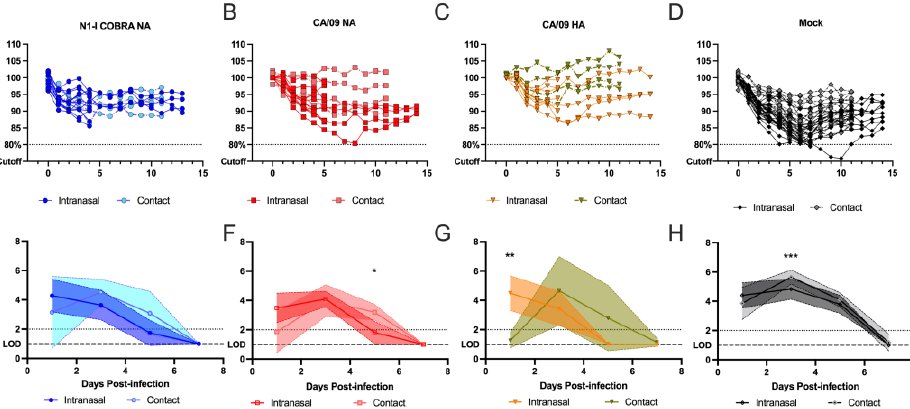
Figure 10. Magnitude of weight loss and viral loads did not change based upon intranasal or contact transmission inoculation method. Vaccinated animals that were challenged by either direct intranasal inoculation (intranasal) or through contact transmission from an intranasally inoculated cage mate (contact) were compared by offsetting the contact weights by three days and the nasal wash titers by two days. The offset days were chosen to maximize the alignment of the mock-vaccinated animals ( D , H ). Each individual ferret’s weight loss over time was depicted for each vaccine group ( A – D ). The average nasal wash titer with standard deviations were depicted for each vaccine group as well ( E – H ). Comparisons were conducted within vaccine groups with a two-way repeated measured ANOVA and Sidak’s multiple comparison test. The minimum weight before clinical endpoint was 75%, with 80% denoting an increase in clinical scoring. The limit of detection (LOD; dashed line) was 1.0 log 10 (PFU/mL), and the limit of quantification (dotted line) was 2.0 log 10 (PFU/mL). Adjusted p- value: * ≤ 0.05, ** ≤ 0.01, *** ≤ 0.001.